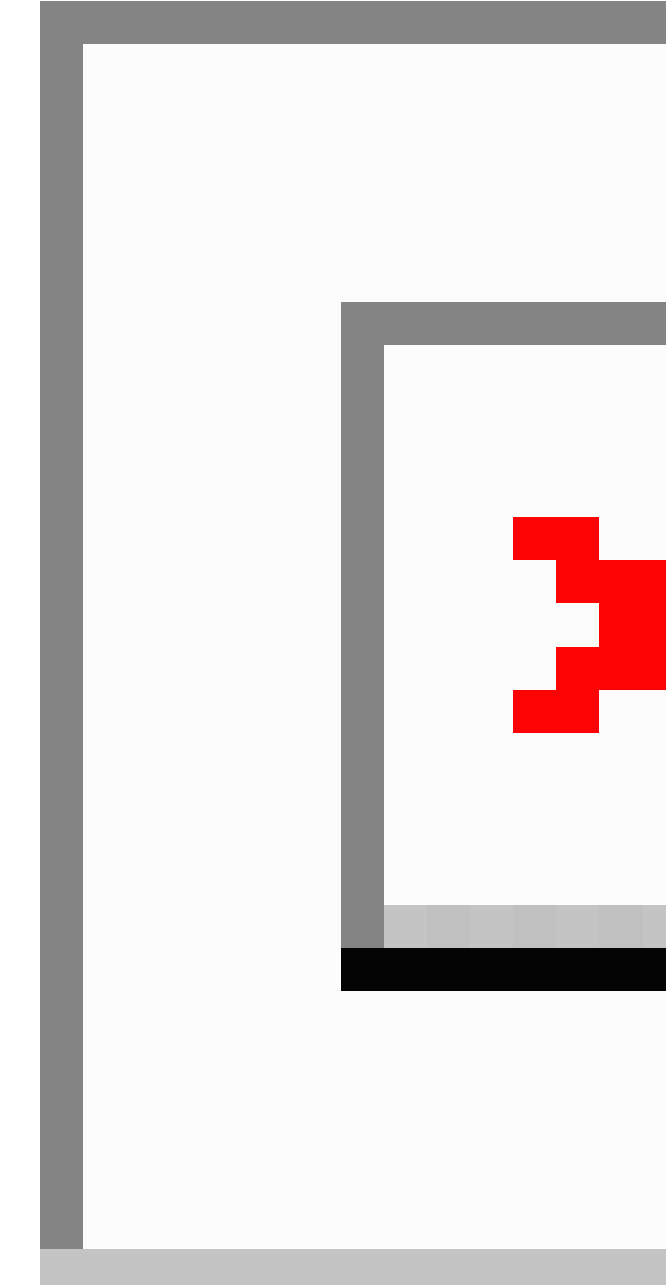
Figure 1. Homepage of the Fun without Smokes